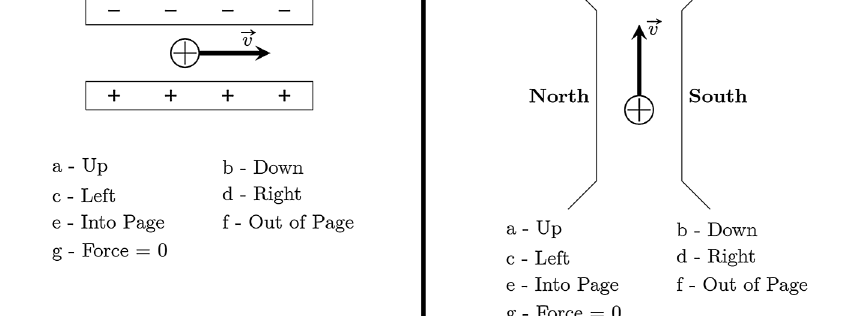
FIG. 2. Example showing question text and illustrations received by students who were questioned with the pole representation. Each student answered four questions in which the direction (up and right) and type (electric and magnetic) of field were varied.